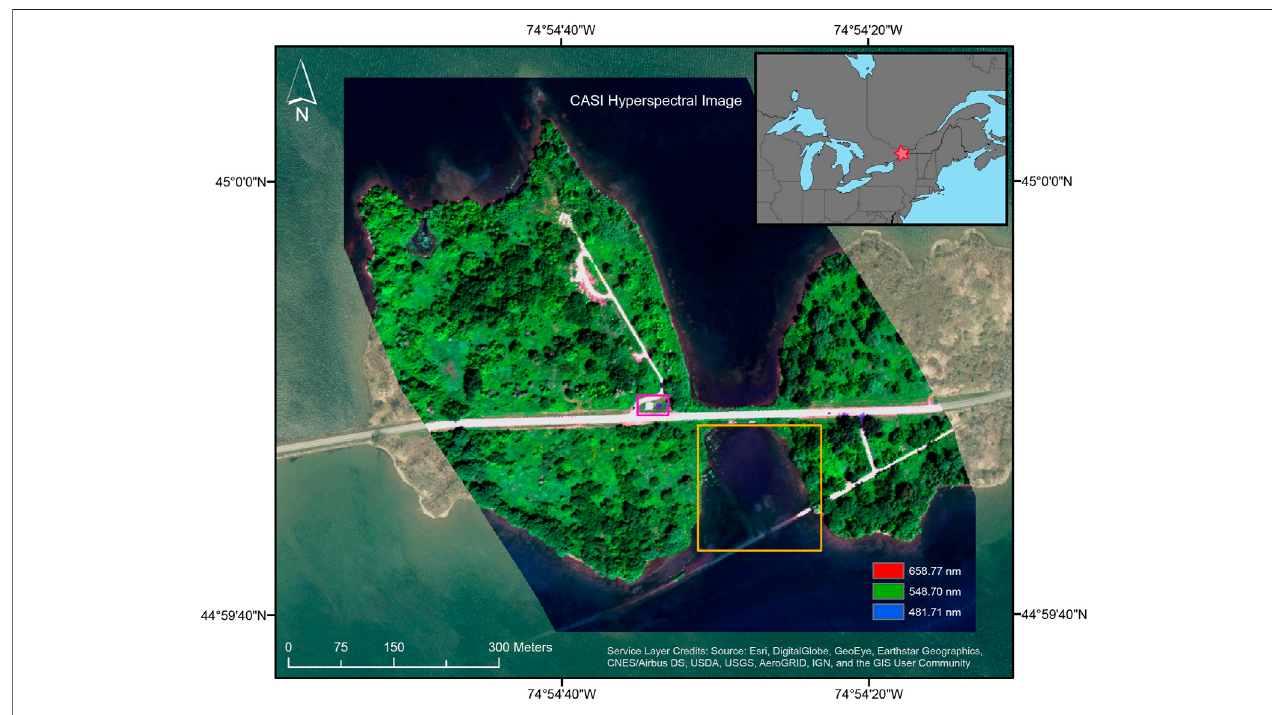
FIGURE 1 | Subset of CASI airborne hyperspectral imagery (red (cid:1) 658.77 nm, green (cid:1) 548.70 nm, blue (cid:1) 481.71 nm) presenting the study site west of Philpott ’ s Island in the Long Sault Parkway recreation area, Ontario, Canada. The yellow box outlines the shallow bay where samples were collected and SAV is mapped. The location of the two calibration tarps is shown in purple. The inset indicates the study site location (red star) in relation to the North American Great Lakes.